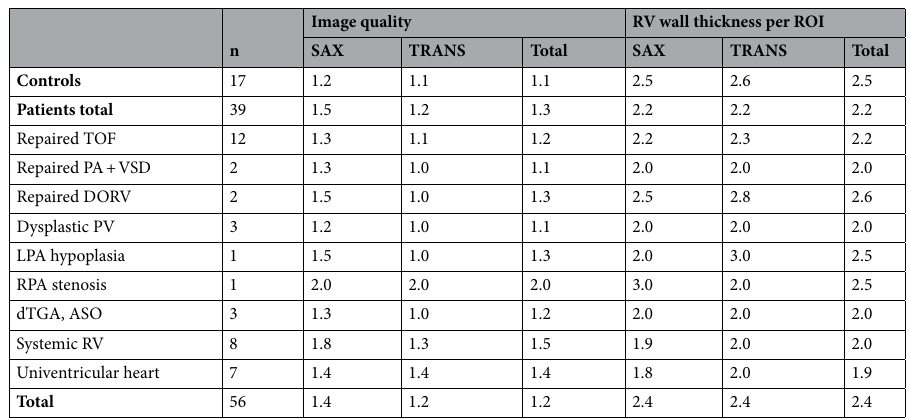
Table 3. Distribution of grades for image quality and right ventricular wall thickness. Mean grades for image quality and maximum RV wall thickness per ROI are given. Image quality: grade 1: no artifacts in RV, good contrast between blood and myocardium; grade 2: minor artifacts in RV, good/sufficient contrast between blood and myocardium; grade 3: major artifacts in RV and/or insufficient contrast between blood and myocardium. Maximum RV wall thickness per ROI: grade 1: > 2 pixels; grade 2: 1–2 pixels; grade 3: < 1 pixel. ASO = arterial switch operation; DORV = double outlet right ventricle; dTGA = d-transposition of the great arteries; LPA = left pulmonary artery; PA + VSD = pulmonary atresia with ventricular septal defect; PV = pulmonary valve; ROI = region of interest; RPA = right pulmonary artery; RV = right ventricle; SAX = short axis; TOF = tetralogy of Fallot; TRANS =